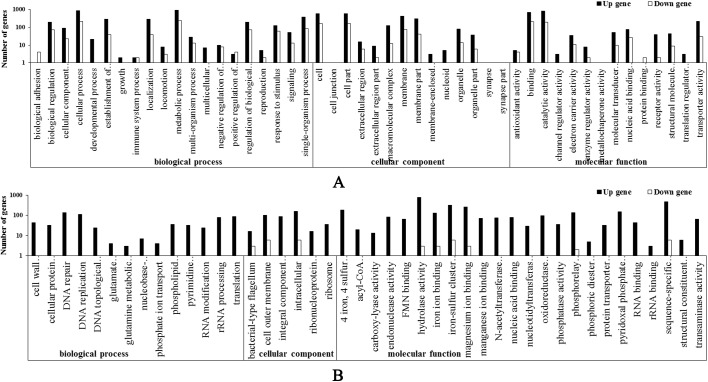
Gene Ontology terms for DEGs grouped into functional categories.The vertical and horizontal coordinates represent the number of genes and the GO functional terms, respectively. Red, upregulated genes; green, downregulated genes. A: resistant strain TN4; B: resistant strain TW4.